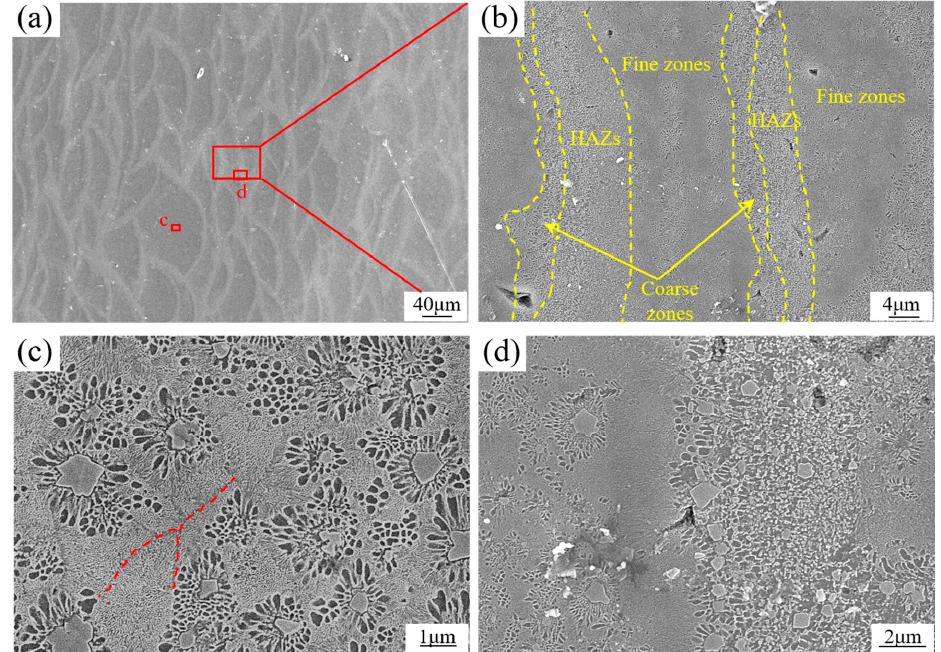
Figure 7. The microstructure of the as-built Al-Si samples in side view. The scan tracks (white zones) morphology of the top surface of the sample etched with Keller’s are visible in the SEM image ( a ). The structure in the red frame in the picture ( a ) is magnified to ensure visibility in the picture ( b – d ). In picture ( b ), fine zones and coarse zones are distinguished by yellow dash lines as well as the HAZs. The morphologies of fine zones and HAZs are illustrated at higher magnifications in the picture ( c , d ). The solidification mechanism in SLMed Al-22Si-0.2Fe-0.1Cu-Re alloy is believed to be cellular-dendritic and eutectic [13]. Due to the liquid oscillations and temperature pro- file, an inhomogeneous structure is formed in the molten pools [28]. According to the Al- Si binary phase diagram, Si phase nucleates firstly in the Si-rich area, which is regarded as the heterogeneous nucleation mechanism with the detailed process being that the grains remain from the partially molten zone or laser spatters land onto the molten pool as the possible nucleation center [13]. The solidification front rejects Al into the liquid with the growth of Si particles. As a result, the solvent Al is enriched in the undercooled liquid surrounding the Si particle, then the α -Al phase solidifies as a cellular structure in the Al- rich area with residual Si segregated at the cellular boundaries around the Si phase, which exactly hinders the growth of the primary Si phase [40]. Subsequently, the component of the liquid is transferred into the eutectic zone. The eutectic phase is solidified both around the already generated phase and in the liquid phase, where equiaxed grains are eventually formed, separated by grain boundaries. Moreover, ultrafine fibrous eutectic Si is formed on the matrix because of the rapid cooling rate and high thermal gradients (as high as 10 3 ~10 8 K/s [28]). For the formation of coarse zones and HAZs, the reason is related to the heat effect of the next hatch or layer, which causes the partial remelting of the hatches or layers that are previously-deposited during the SLM process [21,22,41]. The schematic diagram is shown in Figure 8. The temperature reaches its maximum value at the laser contact point and gradually decreases as the distance gets farther. When the temperature is between solidus and liquidus, already-solidified metal is remelted in a semi-solid state [21]. Ac- cording to the Al-Si binary phase diagram, some primary silicon that remains solid be- cause of a high melting point will grow at this temperature range, causing the reduction